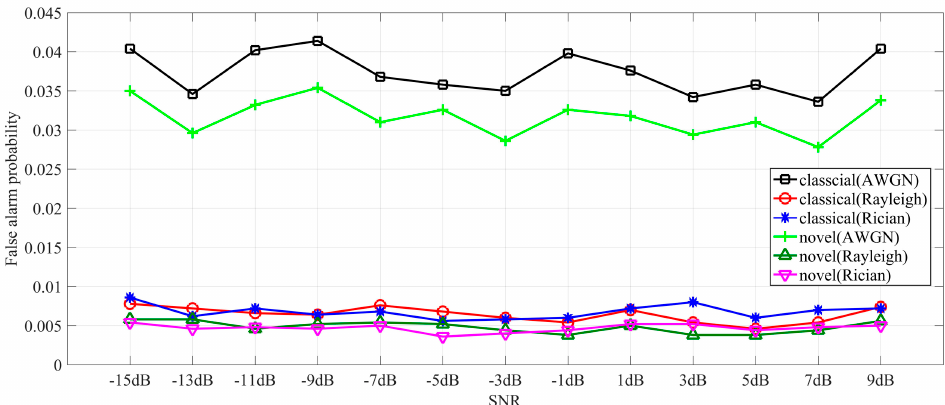
Figure 2. False-alarm probability comparisons when sensing performance is optimal. Appl. Sci. 2019 , 9 , x FOR PEER REVIEW